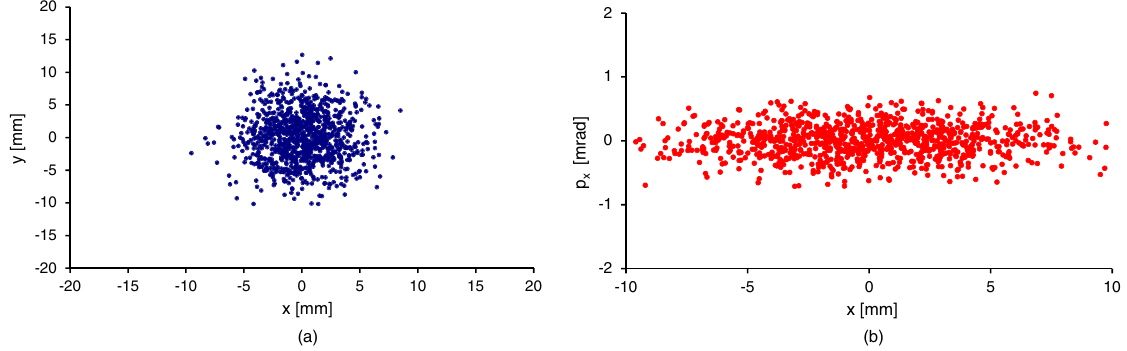
FIG. 13. Snapshots of a CF þ beam injected into the TSR ring in the middle of straight section. Initial beam emittance is " in x;y ¼ 1 (cid:4) mm mrad (rms): (a) simulated beam spot in the x - y cross section where (cid:11) rms x ¼ 2 : 2 mm and (cid:11) rms y ¼ 2 : 4 mm ; (b) beam image in x - x 0 phase space corresponds to 4 rms emittance " in (cid:9) 6 (cid:4) mm mrad x;y